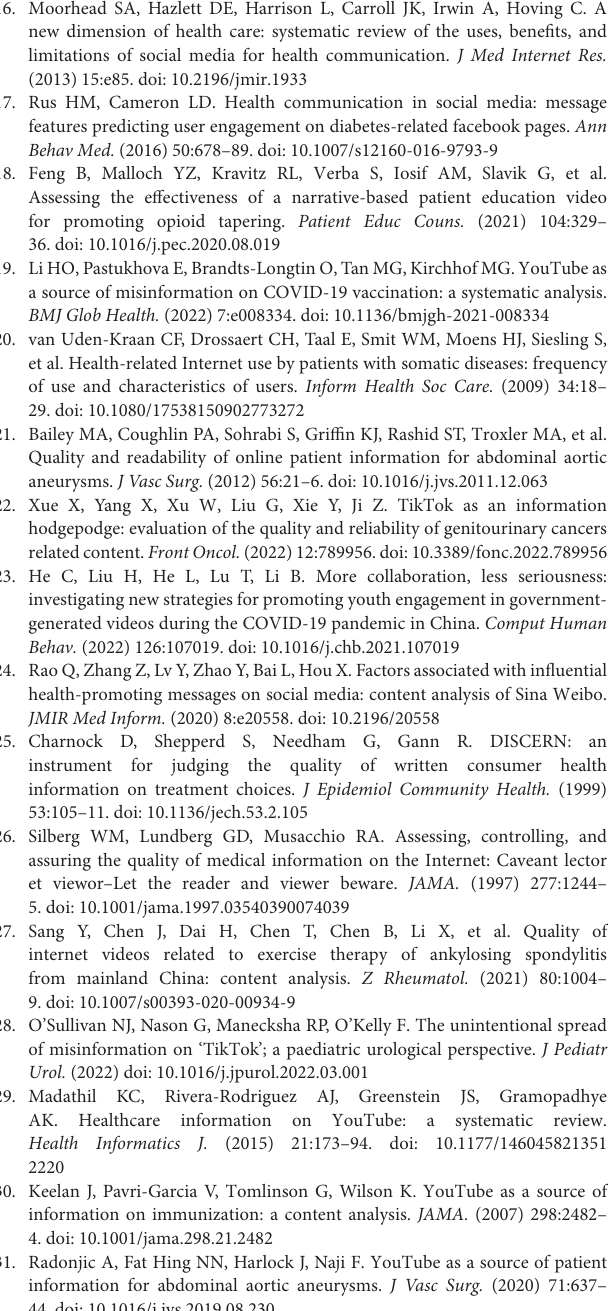
Supplementary Figure 1 | Detailed results of questionnaires for included videos in DISCERN and JAMA benchmark criteria. Each rectangular unit corresponds to